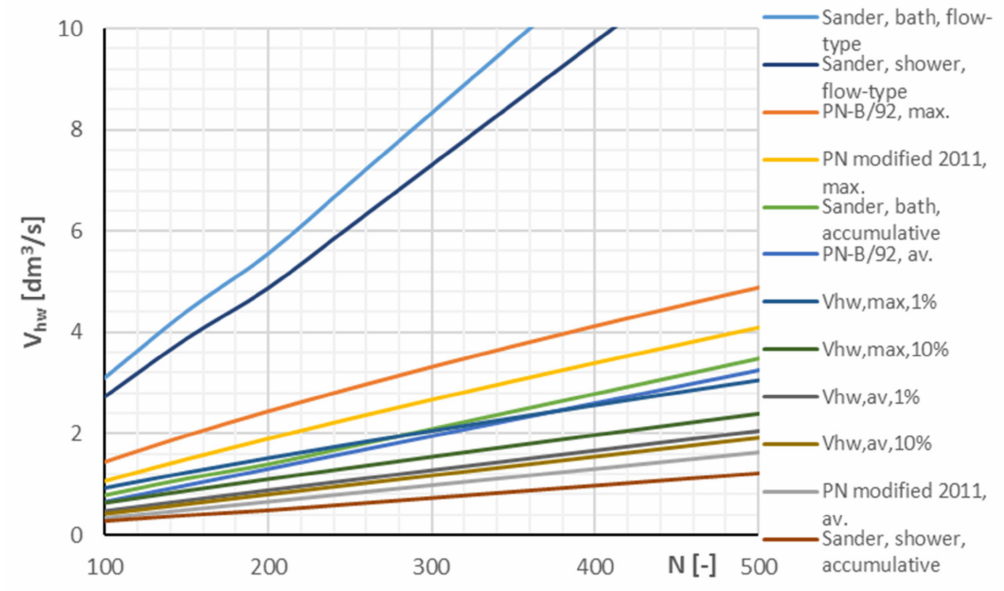
Figure 5. Comparison of hot water consumption calculated with different formulas, the number of flats: N =